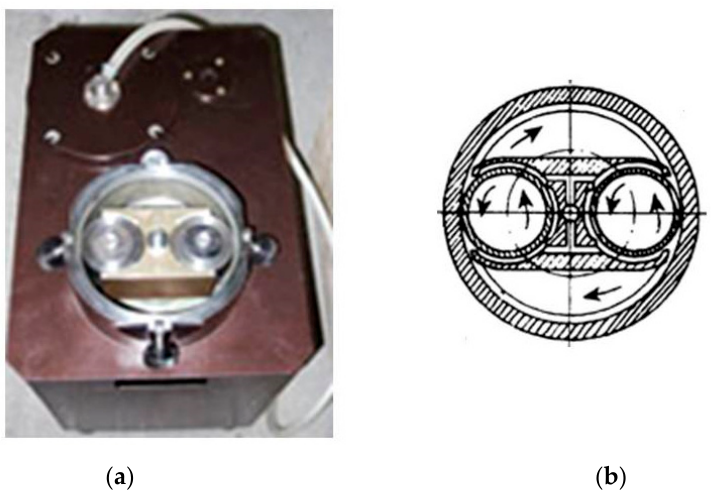
Figure 1. ( a ) A general view of an AGO-2 mill without a lid: two vials and a planetary carrier are rotating inside the casing. ( b ) A schematic (top view) of an AGO-2 mill: the vials are in planetary motion.